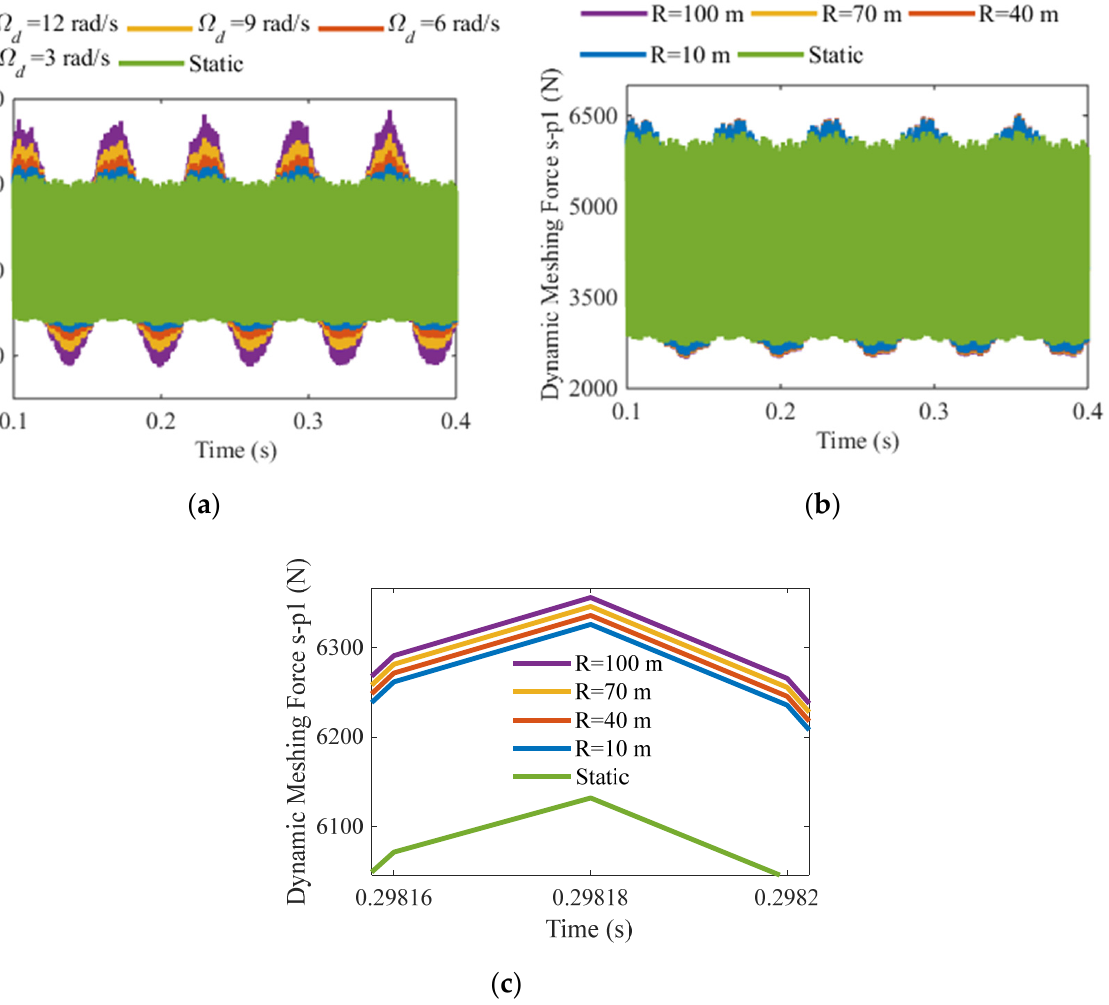
Figure 11. The time domain responses of the dynamic meshing force of sun-planet1. ( a ) At different LAV; ( b ) At different LR;. ( c ) Partial enlargement.